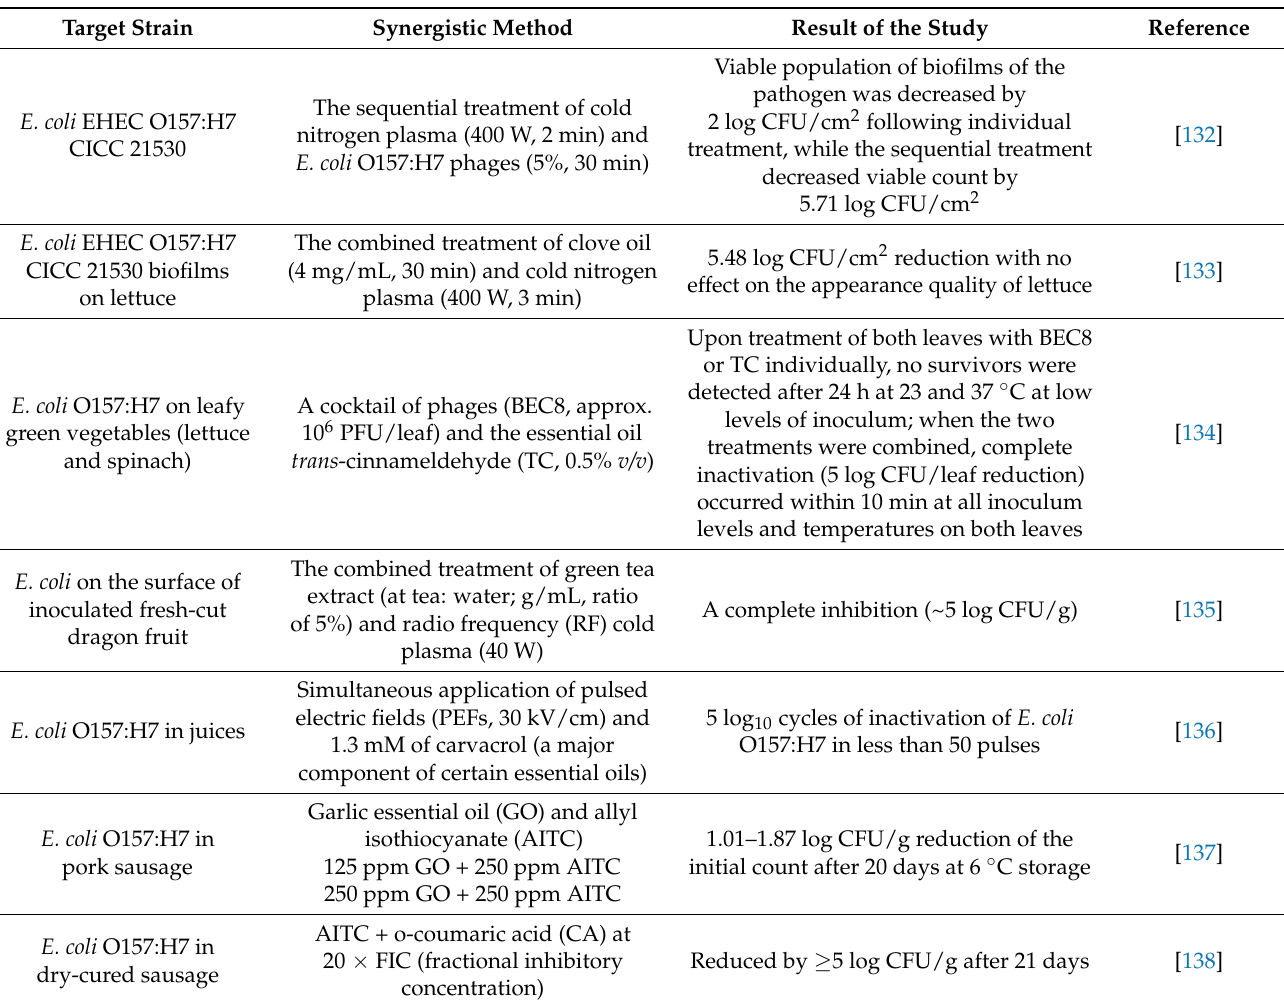
Table 3. Synergistic effects of combinations of biocontrol agents or a biocontrol agent together with another antimicrobial agent against E. coli